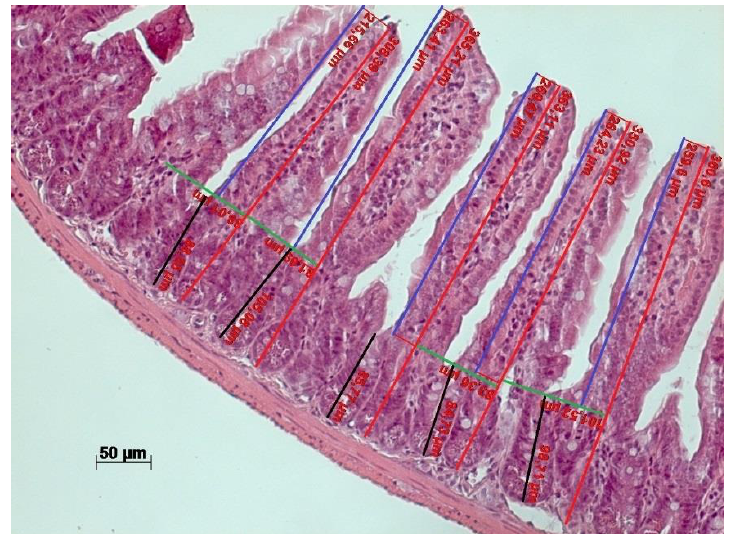
Figure 1. Schematic representation of measurements of intestinal morphology parameters. The vertical red lines correspond to mucosal thickness, blue lines indicate villus length, black lines indicate crypt depth and horizontal green lines demonstrate how villus spacing was determined.